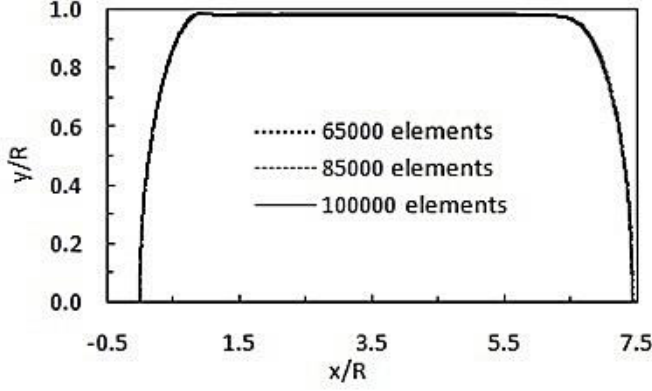
Figure 4. Droplet shape for different mesh sizes